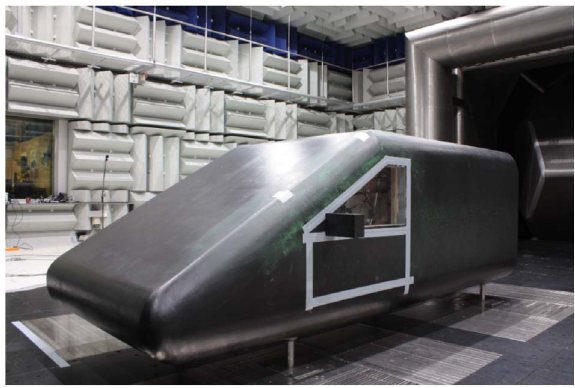
Figure 2. Simpli fi ed car model in acoustic wind tunnel